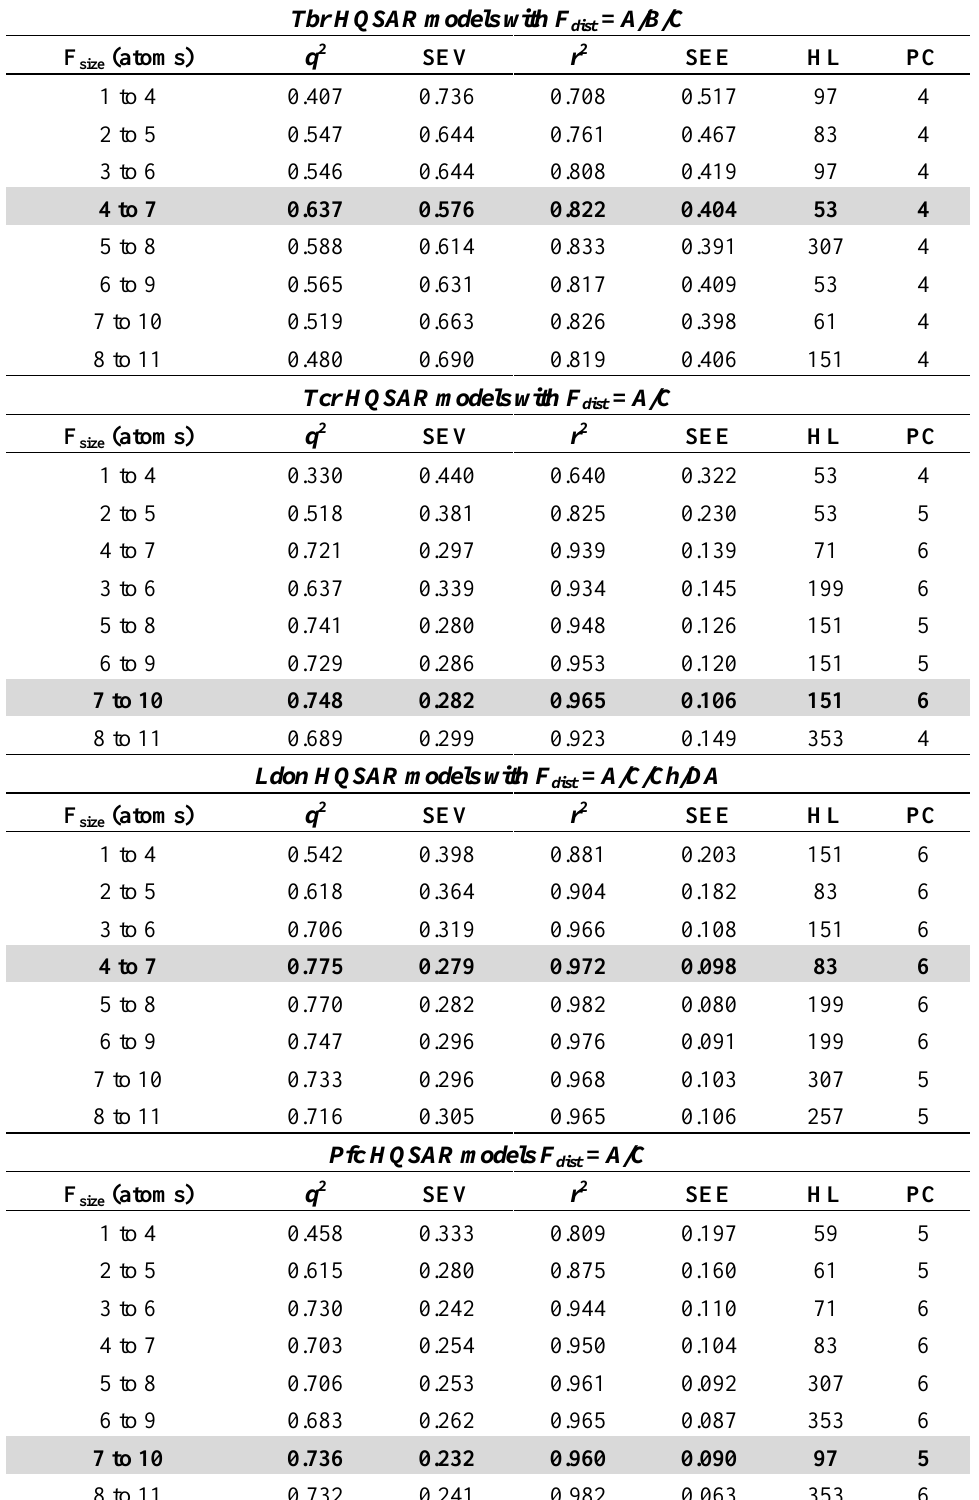
Table 2. HQSAR models with fragment size variations from 1–4 atoms to 8–11 atoms. Tbr HQSAR models with F = dist